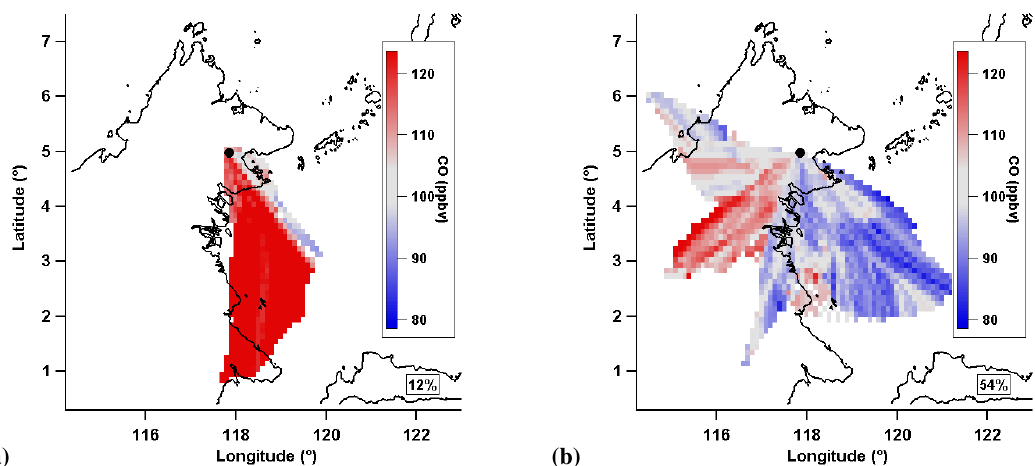
Fig. 17. Mean value maps of CO during (a) POI 1 and (b) POI 2. Colour scale is centred round the median value of the CO mean value map for the whole campaign.